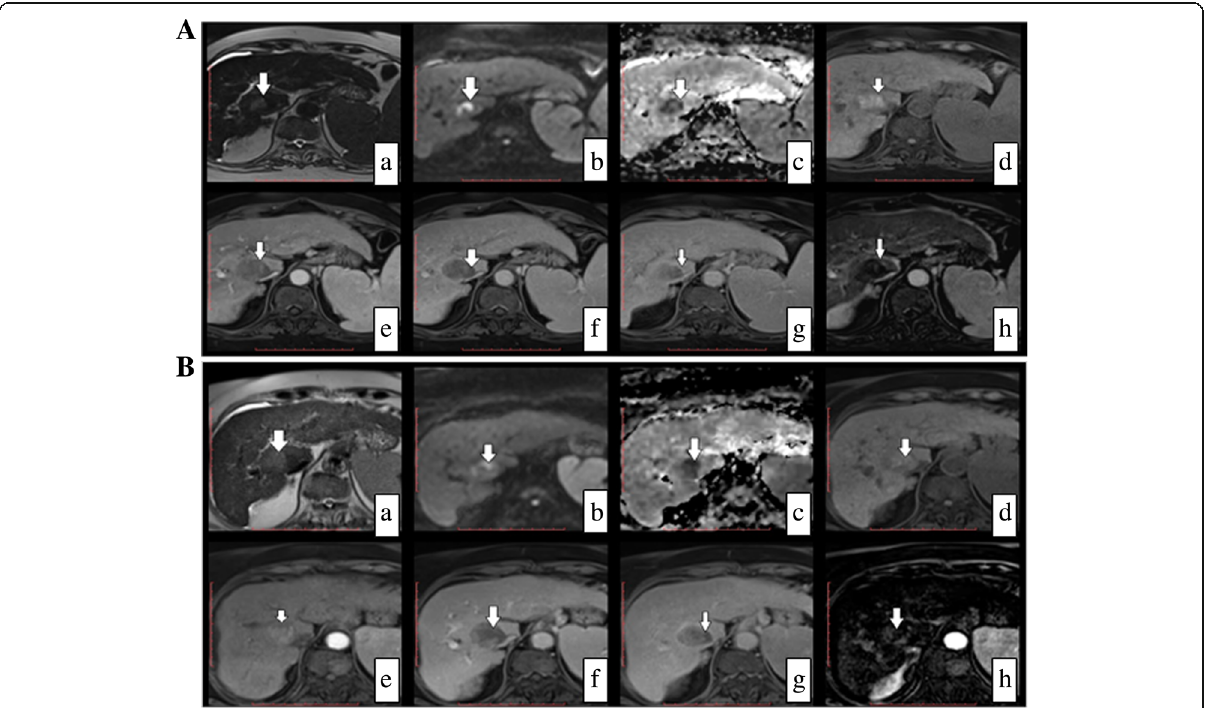
Fig. 6 A 64-year-old female patient with hepatitis-related liver cirrhosis and single segment I HCC lesion. She had a TACE session and came for follow up 1 month later. (A) Follow up dynamic MRI 1 month post TACE. a T2WI, b DWI image, c ADC image, d T1WI, e late arterial phase, f Portal phase, g delayed phase, and h late arterial subtracted image. The treatment zone elicits high heterogeneous signal in both T1WIs and T2WIs with the periphery of the lesion is seen of restricted diffusion. NO clear areas of enhancement could be seen in the dynamic study; however, the subtraction images shows faint lesion enhancement (false negative dynamic study interpretation). (B) Follow up dynamic MRI 3 months post TACE. a T2WI, b DWI image, c ADC image, d T1WI, e late arterial phase, f portal phase, g delayed phase, and h late arterial subtracted image. The enhancement became more clear and more appreciated in the dynamic and subtraction images